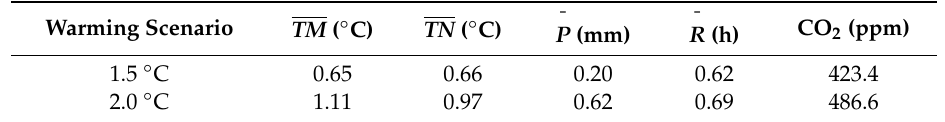
Table 2. Change in climatic variables under the 1.5 and 2.0 ◦ C warming scenarios relative to the baseline time 1